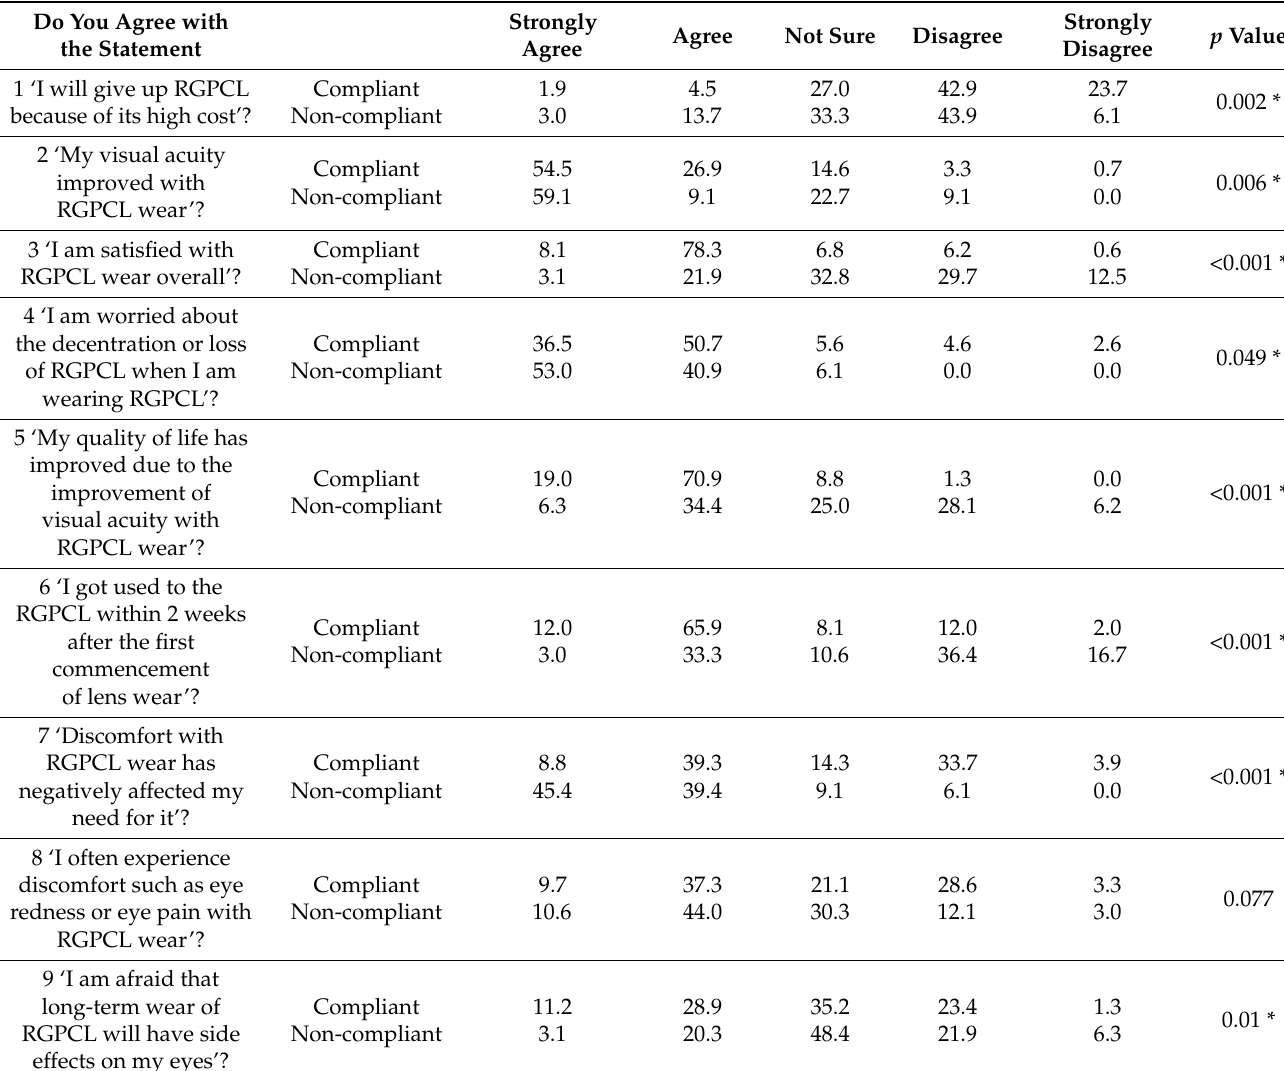
Table 4. Comparison of different answers to the questionnaire survey between the compliant and non-compliant groups (308 eyes, compliant; 66 eyes, non-compliant)